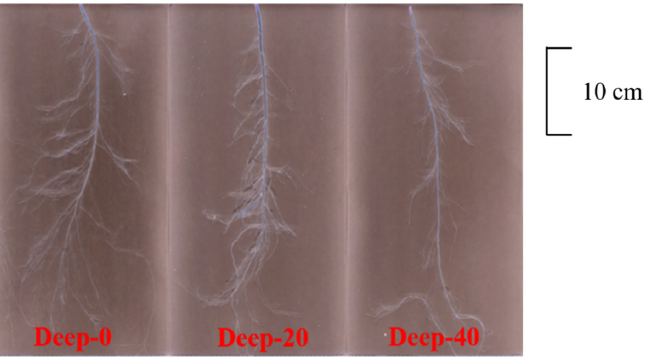
Figure 2. Scanned images of the alfalfa root system under three drip irrigation depths.